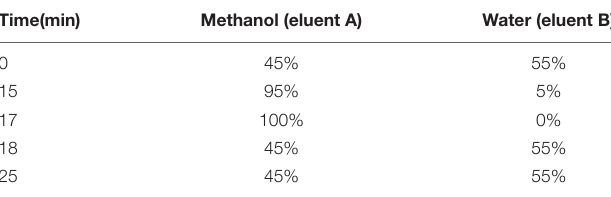
TABLE 1 | Elution procedure of polyamines separation in watermelon